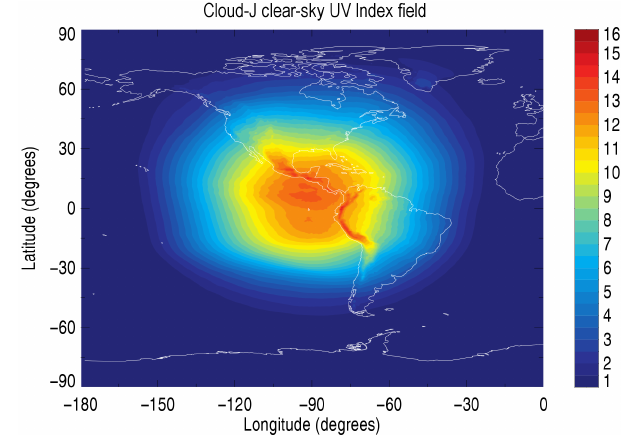
Figure 3. Cloud-J clear-sky UV Index field produced using GEM 6h forecast data with the OMI and GEISA spectral parameters de- tailed in Sect. 2.1. The UV Index field was generated from a 7-day average of spectral irradiances produced from 23 to 29 August 2015 at